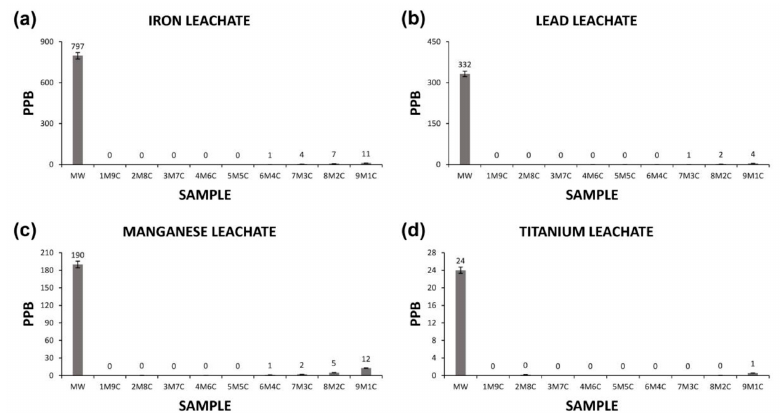
Figure 7. Leaching tests of chemical elements contaminating for the ceramic families with clay and mining residue and the unaltered mining residue sample. ( a ) Iron leachate, ( b ) Lead leachate, ( c ) Manganese leachate and ( d ) Titanium leachate.